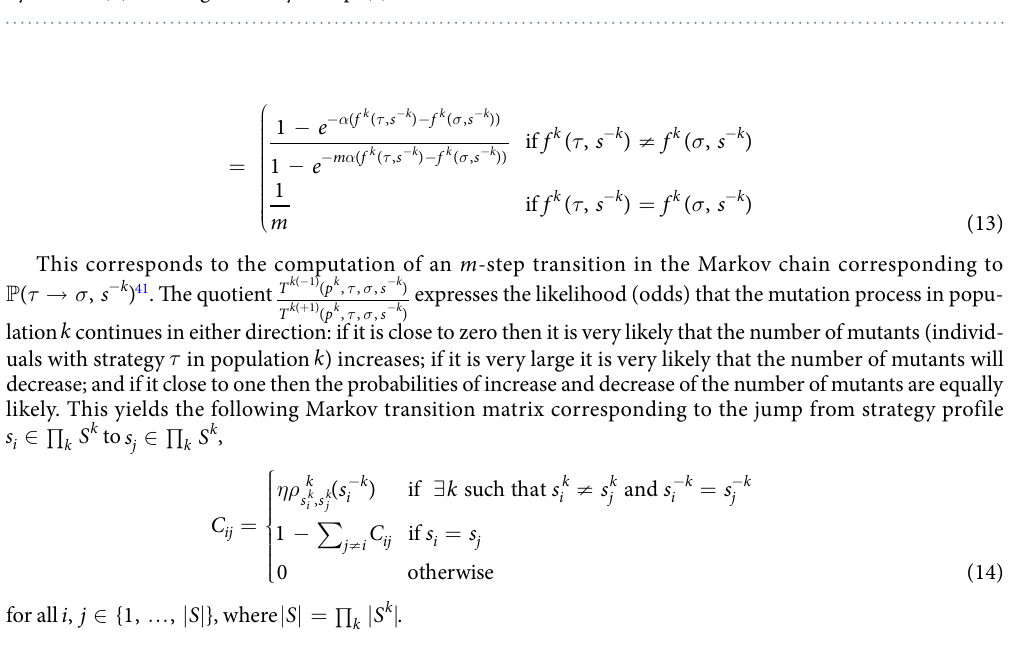
Figure 15. 4-player Kuhn poker (ranking conducted on all 256 pure strategy profiles). ( a ) Discrete-time dynamics. ( b ) Ranking-intensity sweep. ( c ) α -Rank